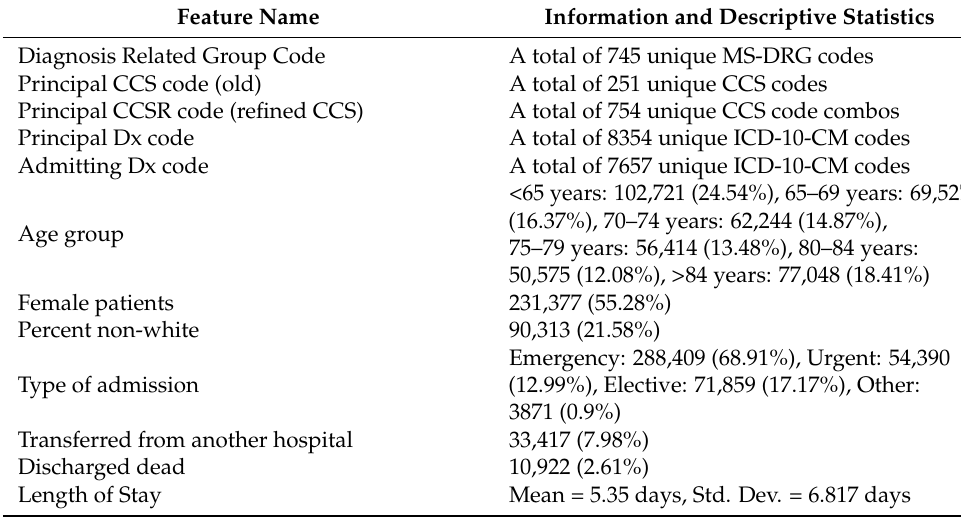
Table 2. Description of